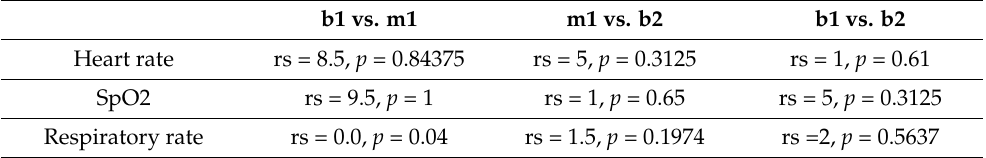
Table 4. Wilcoxon signed rank test for median values of heart rate, SpO2, and respiratory rate for three experimental blocks: baseline 1 (b1), music 1 (m1), and baseline 2 (b2). rs = rank statistic. b1 vs.